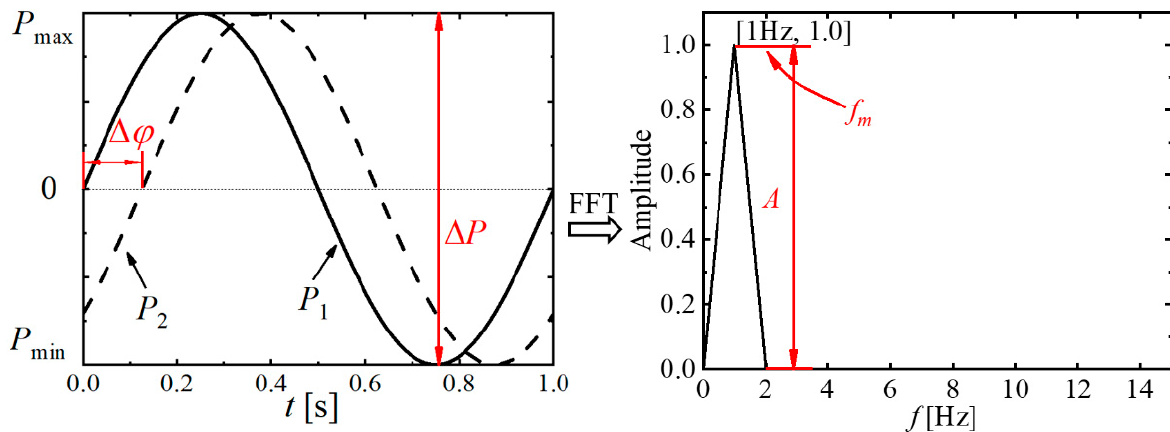
Figure 3. A and f m for the propagation of a signal.